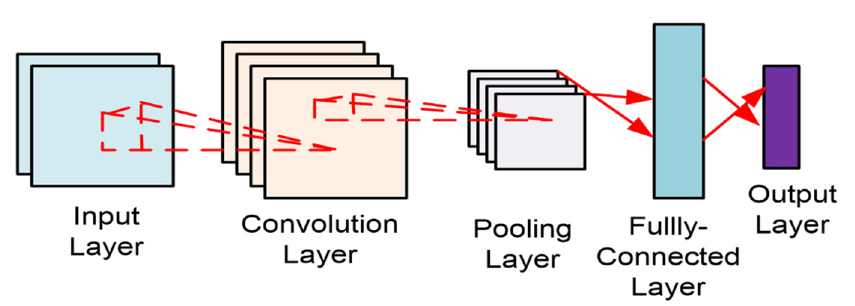
Figure 3. Architecture of CNN.